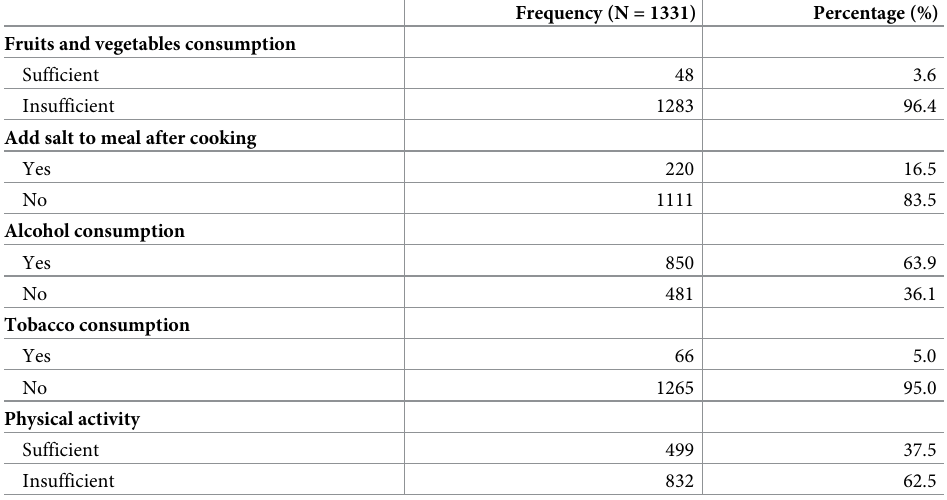
Table 1. Distribution of surveyed subjects according to the behavioral risk factors in rural population of Tanv è and De´kanmey in Benin in 2019 (N = 1331).